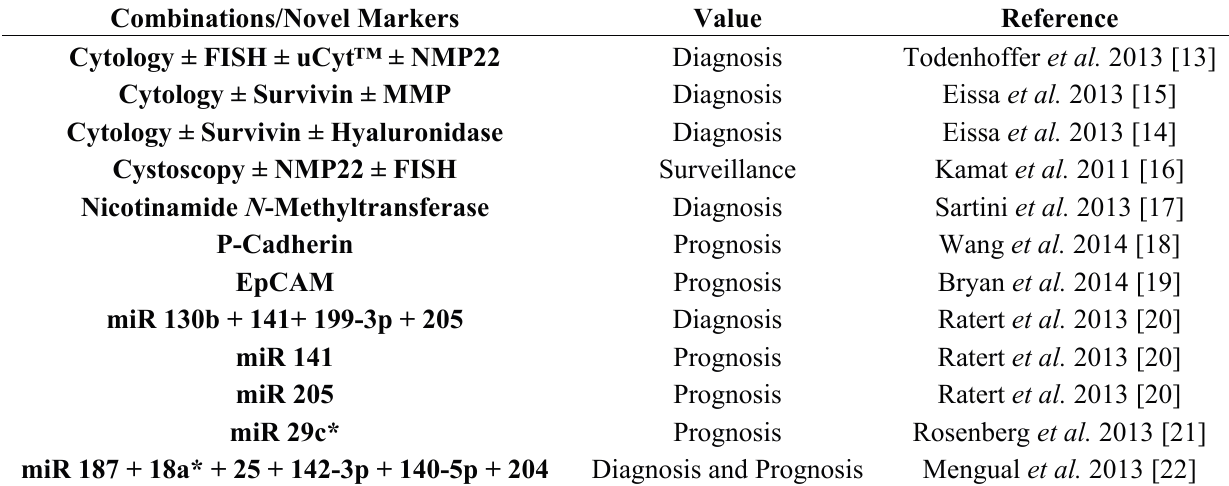
Table 1. Clinical value of novel bladder tumor